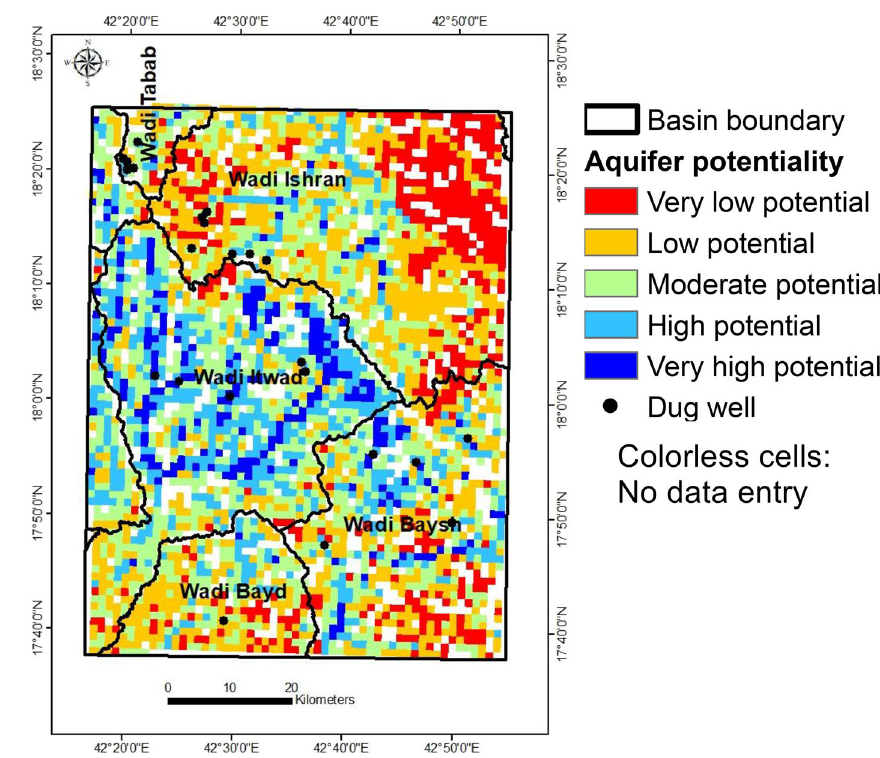
Fig. 12 Groundwater potential zones (GWPZs) map of the study area